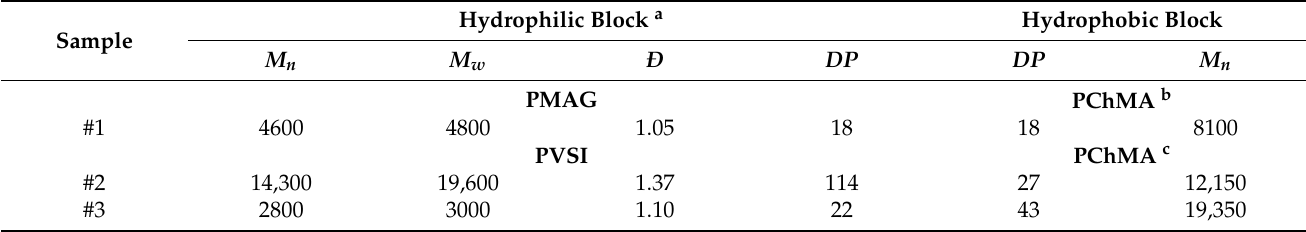
Table 1. The molecular weight characteristics and polymerization degree of amphiphilic block-copolymers. Sample